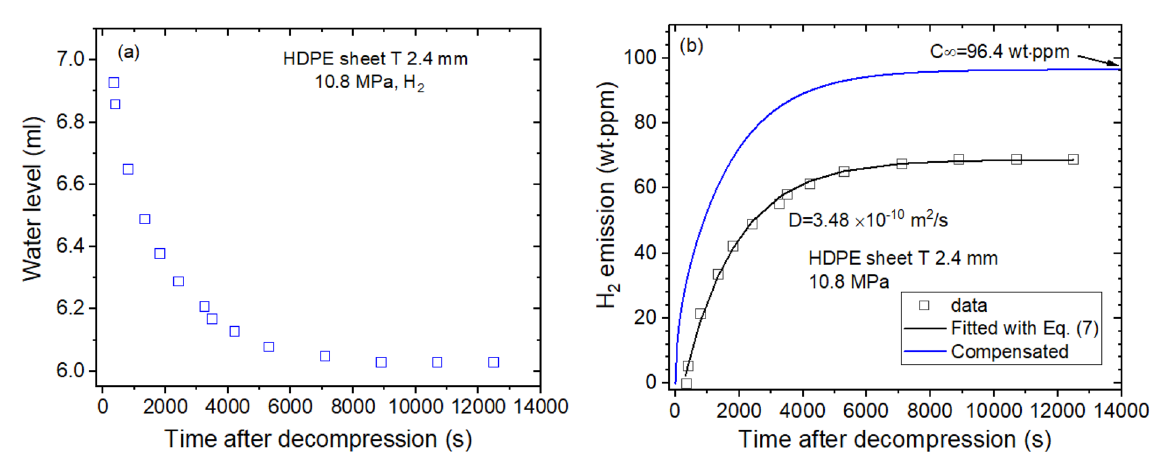
Figure 5. Sequence for obtaining the diffusion parameter in the HDPE sheet. ( a ) Water level versus time after decompression and ( b ) time-varying H 2 mass concentration transformed from the water level. As a result of the experimental investigation, the diffusion parameters D and C ∞ are determined using a diffusion analysis program. The blue line is the total compensated emission curve restoring the missing content for lag time. T indicates the thickness of the sheet